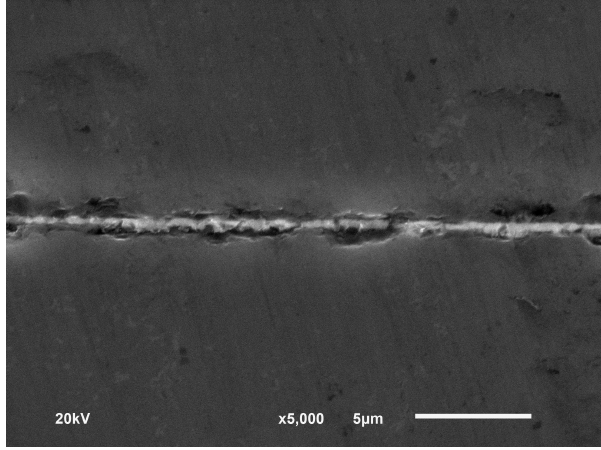
Figure 5. Bonding interface of the SiC layers using the nickel diffusion method with a temperature of 900 °C and a pressure of 42 MPa.